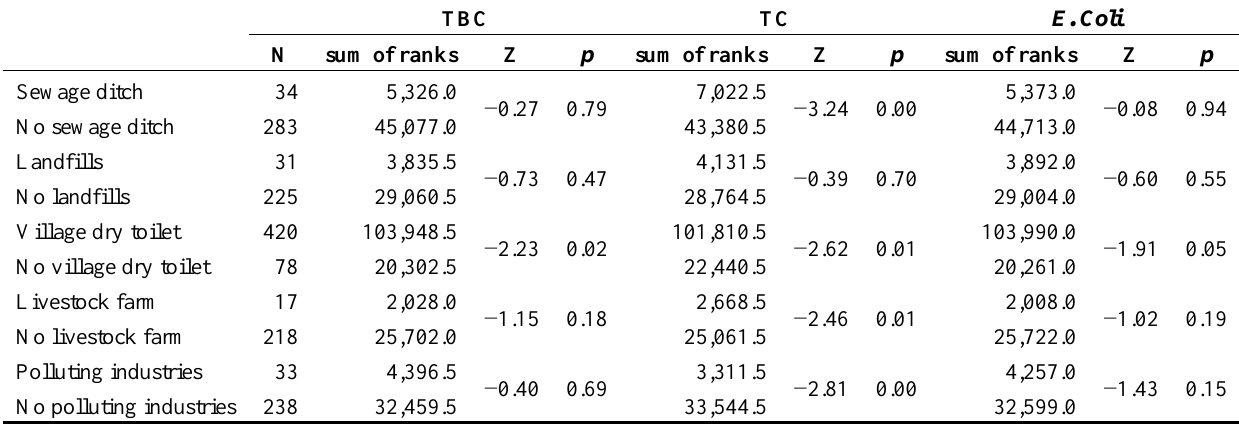
Table 4. Mann-Whitney U test of the contamination sources around water